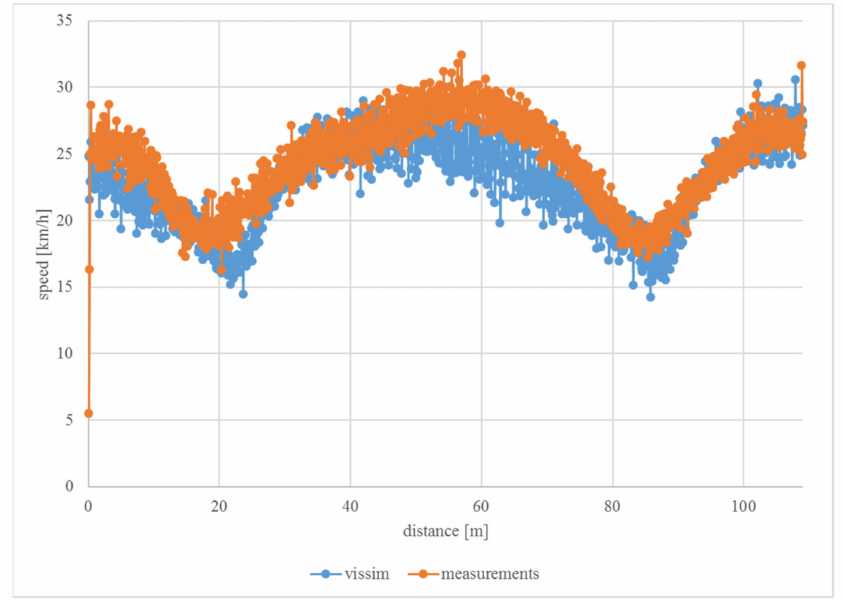
Figure 10. Comparison of speed profiles on the measured street section, heading northbound, source: